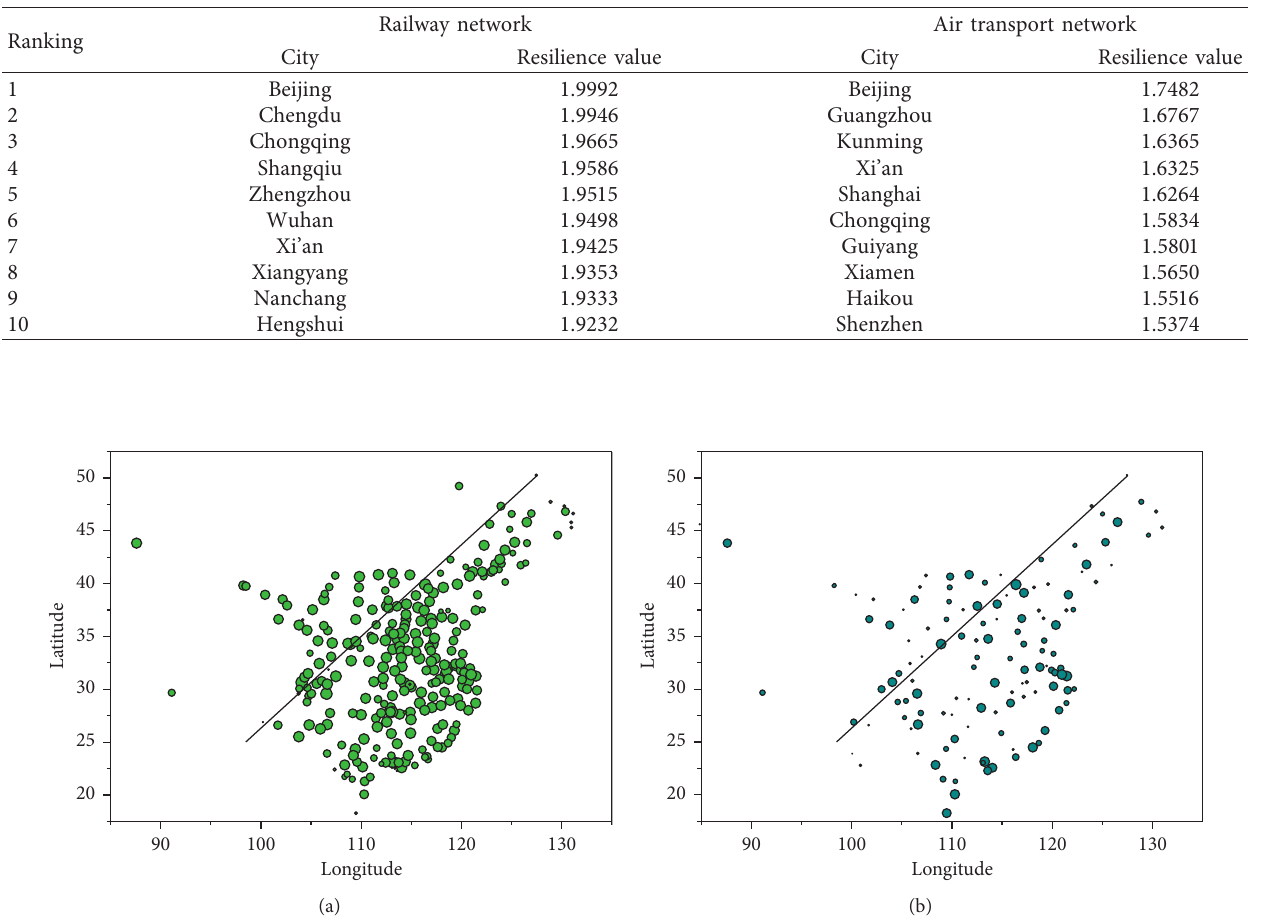
Table 4: Resilience of top 10 cities in China railway and air transport networks.